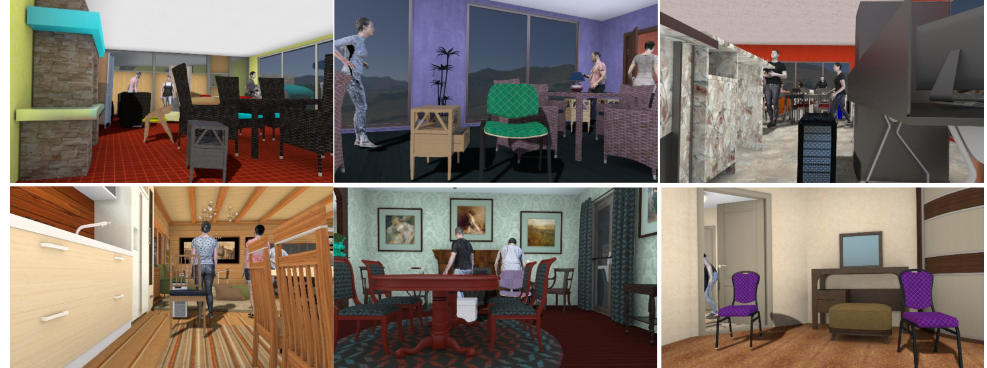
Figure 15. Examples of augmentation of the rendered models in DISCOMAN dataset.